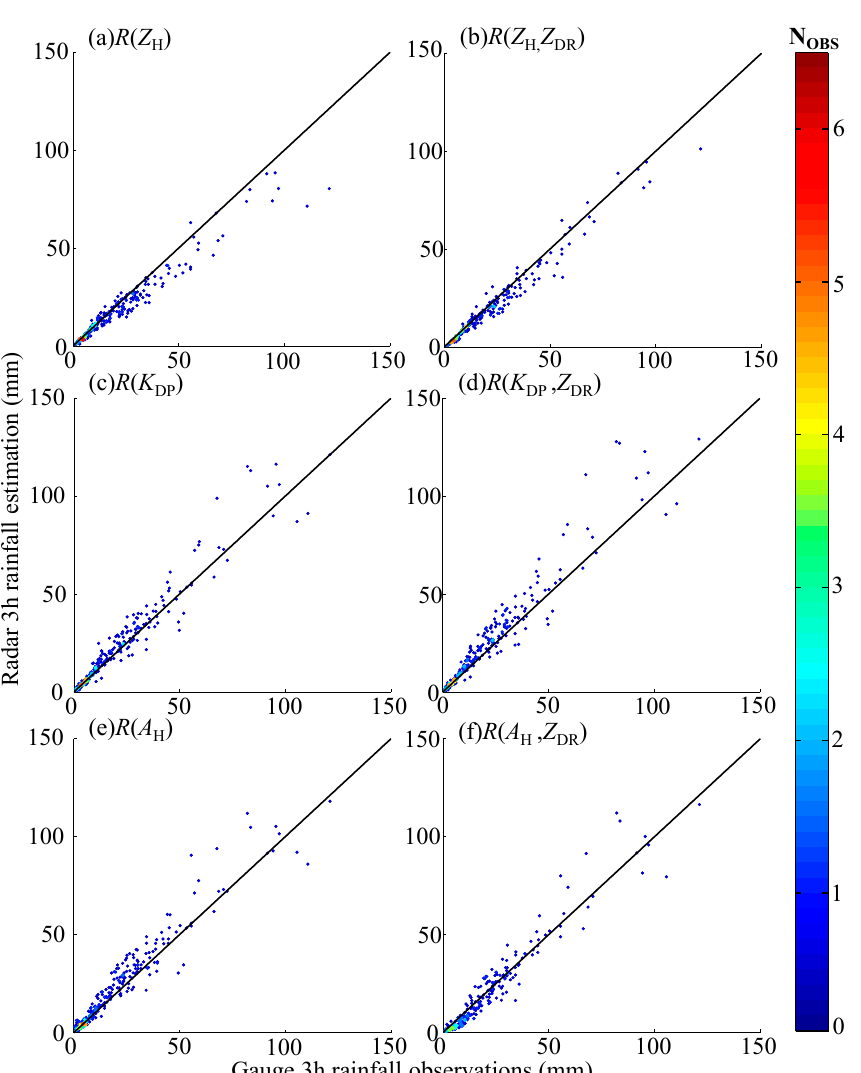
Figure 8. Scattergram of 3-h rainfall estimates from the gauge versus radar using six different radar rainfall estimators at 0500 UTC on 1 June 2016: ( a ) R ( Z H ); ( b ) R ( Z H , Z DR ); ( c ) R ( K DP ); ( d ) R ( K DP , Z DR ); ( e ) R ( A H ); ( f ) R ( A H , Z DR ).